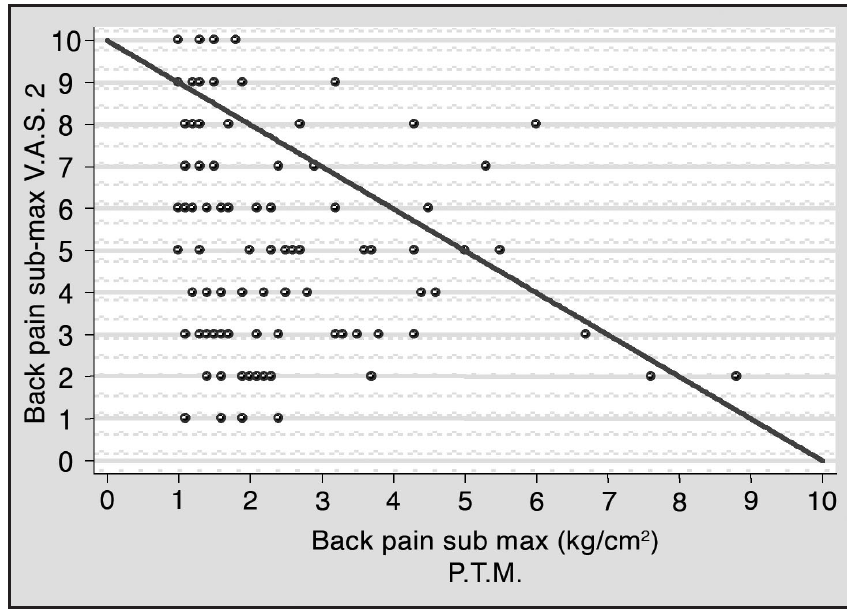
Figure 6: Scatter plot of the sub-maximum pressure pain vs the patient perception on the